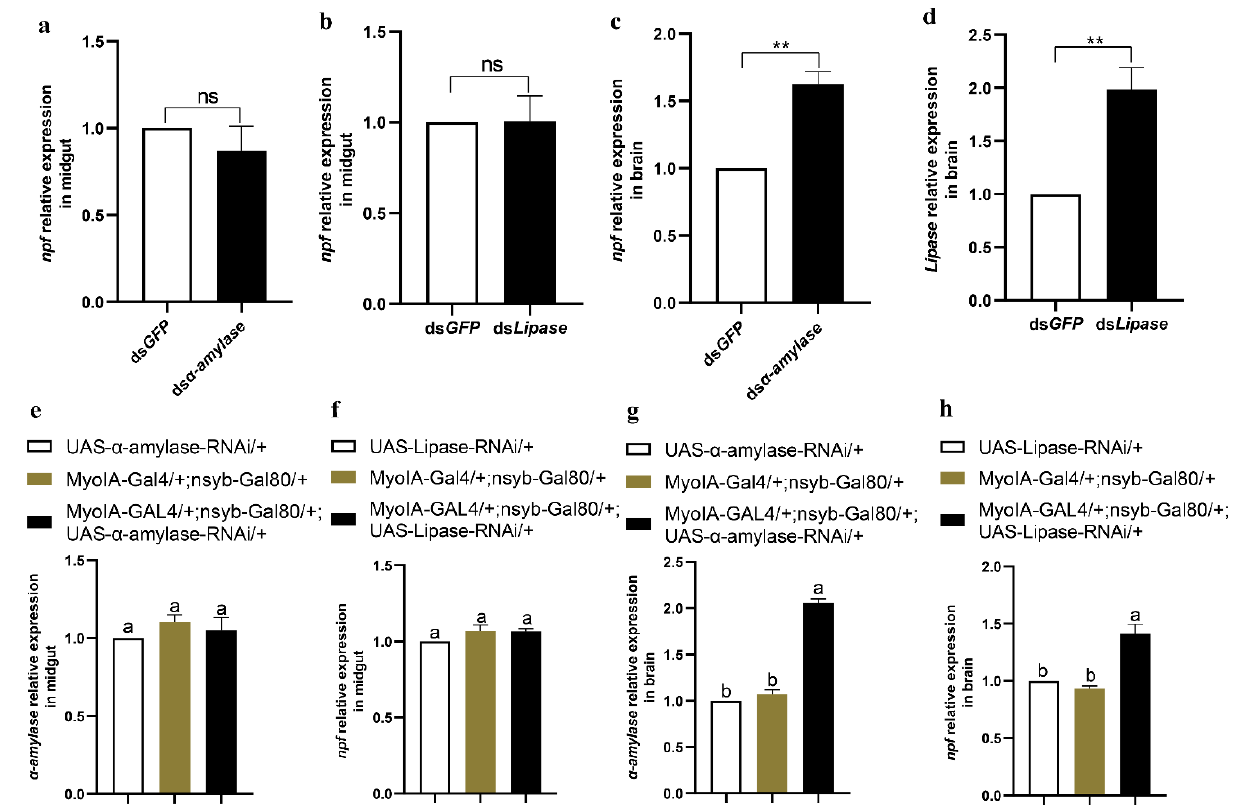
Figure 9. Effects of α -amylase and lipase on npf in the midgut and brain of O. furnacalis and D. melanogaster . ( a – d ) Relative expression levels of npf in the gut and brain after injection of ds α -amylase or ds lipase for 3 h in 5th instar larvae of O. furnacalis . ( e – h ) Relative expression levels of npf in the gut and brain at ZT2 in third instar larvae of D. melanogaster . Each treatment was repeated 3 times with 10 individuals per replicate. Bars represent the mean ± SE, ** p < 0.01. ns indicates no significant difference. Different letters above the bars indicate significant differences at p < 0.05 as determined by Duncan’s multiple range test.